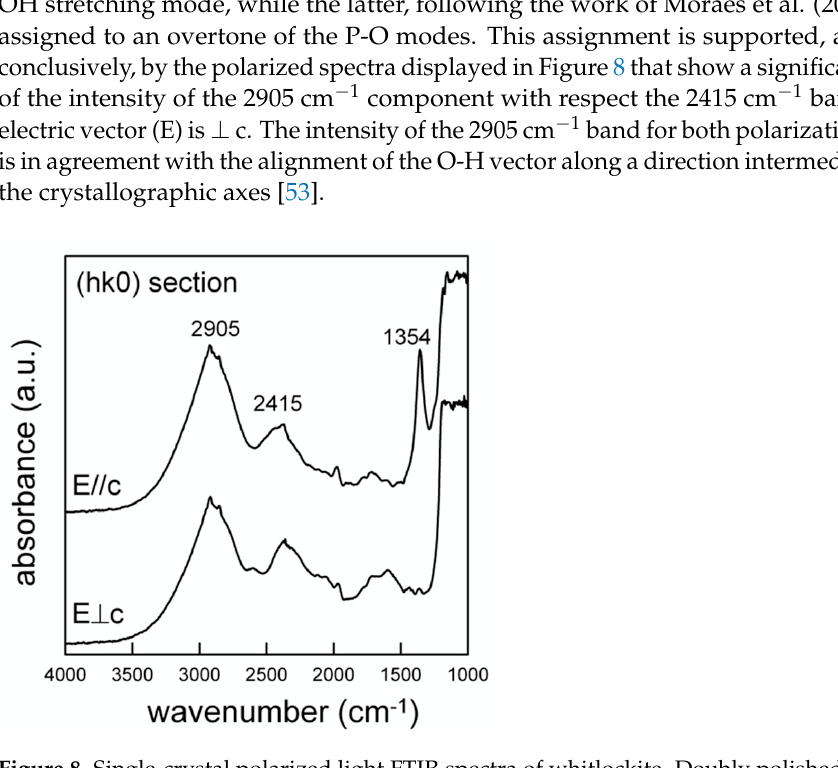
Figure 8. Single-crystal polarized light FTIR spectra of whitlockite. Doubly polished 100 µ m thick (hk0) section.